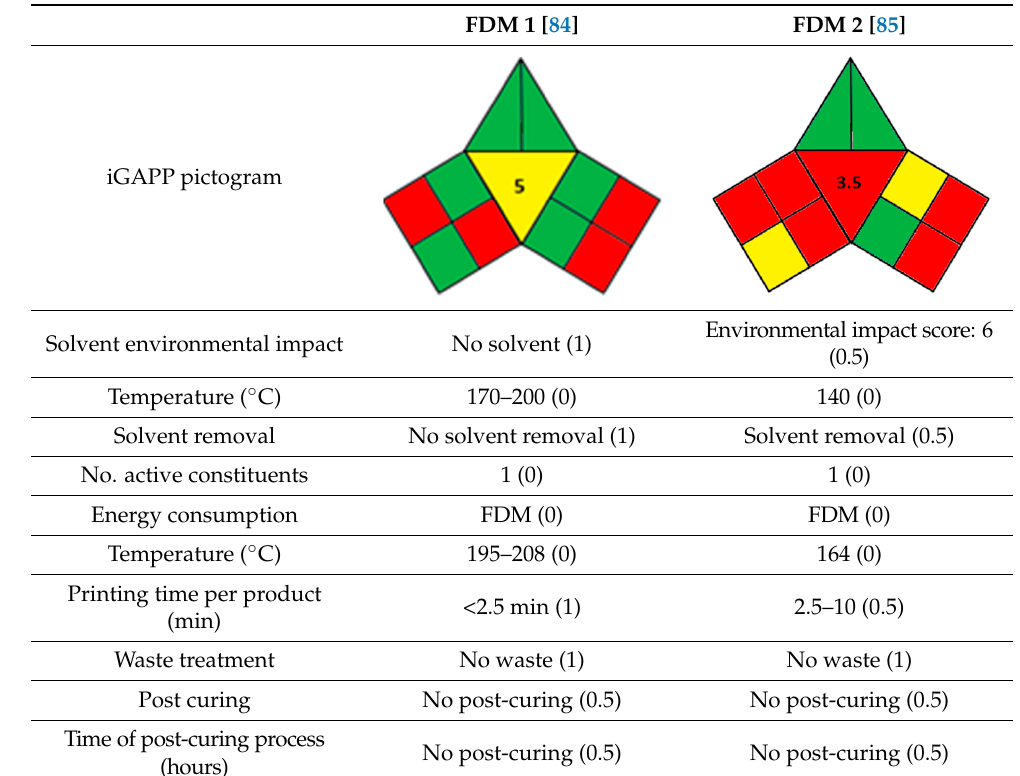
Table 4. Comparative greenness evaluation of two reported FDM methods.